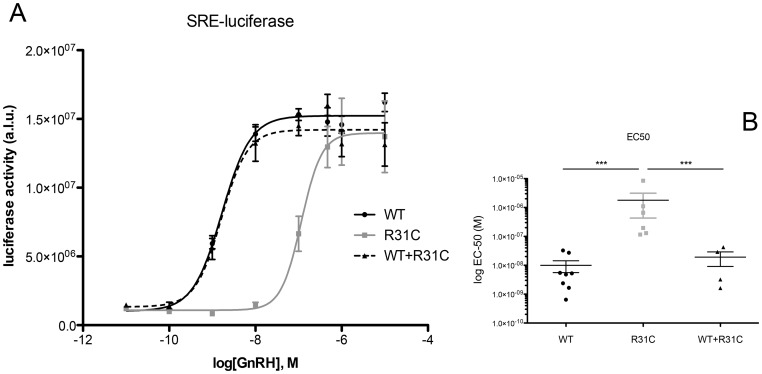
SRE-coupled luciferase assay.(A) HEK293T cells were exposed to graded concentrations of wild type (WT) GnRH, R31C and equimolar concentrations of WT + R31C during five hours. Luciferase activity arbitrary units by luminometry (a.u.) have been shown as ratio on beta-galactosidase activity by optical density used as transfection efficiency internal control. This experience was conducted eight times. (B) Representation of individual values of EC-50 (calculated with Arcsin “P” root transformation) from n = 8 dose-response experiments. WT GnRH EC-50 was calculated at 4±1.2 nM, R31C EC-50 at 313±130 nM. ***p<0.0001.